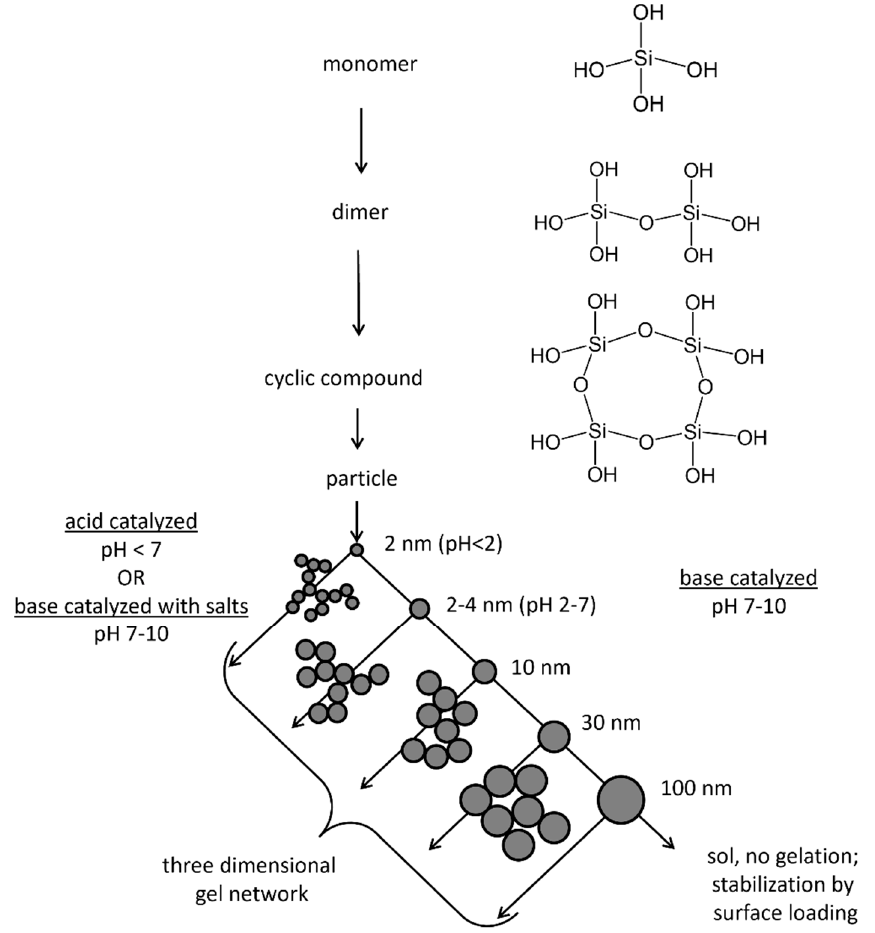
Figure 2. Schematic presentation of the condensation of aqueous silicates, modified from [55,60]. At acidic pH, the solubility of a particle is low, and therefore the particles grow up to 2–4 nm before they are connected first to chains and afterward to networks. These networks spread in the aqueous medium before they finally gel. If the pH is lower than 2, formation and aggregation of particles occur at the same time. After the particles have reached a size of 2 nm, the Ostwald ripening stops, and a network is formed from these small particles. In contrast, at alkaline conditions, the solubility of the particles is higher. Furthermore, the condensed particles are charged, and thus they repel each other. For this reason, an enhanced growth via Ostwald ripening instead of a connection of the particles occurs. In the absence of salts, aggregation is lacking and a stabilized sol is developed [58,64]. At a pH greater than 2, condensation starts with the deprotonation of the silanol group by a hydroxide ion (Equation (7)). Already condensed species are more likely ionized. Afterward, the silanolate anion reacts with another silanol group via separation of a hydroxide ion (Equation (8)). In comparison, the first reaction (Equation (7)) occurs faster than the second (Equation (8)) [58].